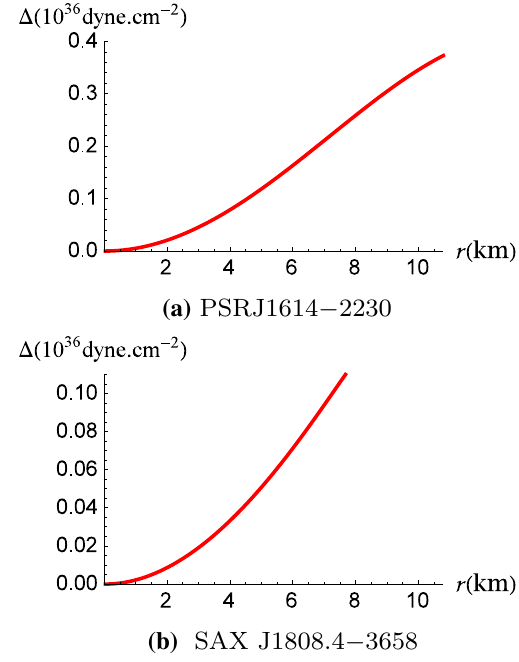
Fig. 2 Variation of energy density verses the radius